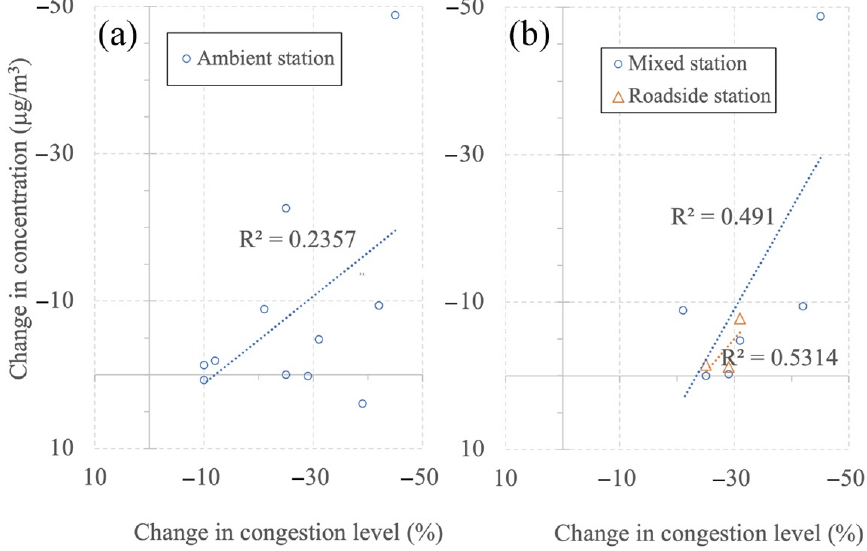
Figure 2. Effect of PM 2.5 from the change in congestion level: ( a ) all ambient stations with or without lockdown and ( b ) all stations with the full lockdown. The colored dash lines (i.e., blue in ( a ), blue in ( b ), and orange in ( b )) indicate the linear best fit for ambient (R 2 of 0.2357), mixed (R 2 of 0.491), and roadside (R 2 of 0.5314) stations, respectively.